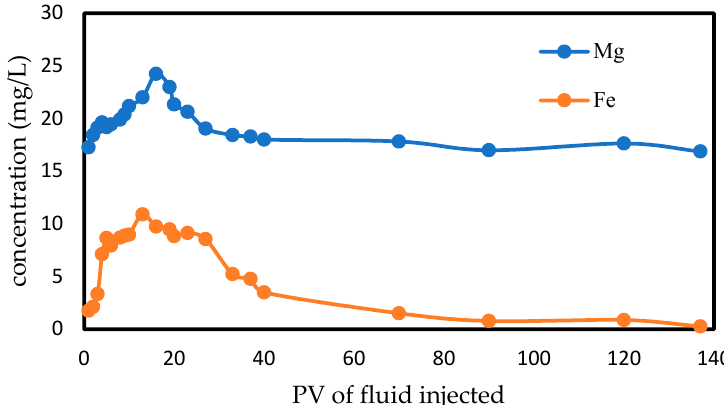
Figure 11. Concentrations of Mg 2+ and Fe 3+ in produced brine along the pore volume (PV) of fluid injected during CO 2 -WAG flooding in core HU24-2. Table 9. Minerals with significant changes in contents after flooding.